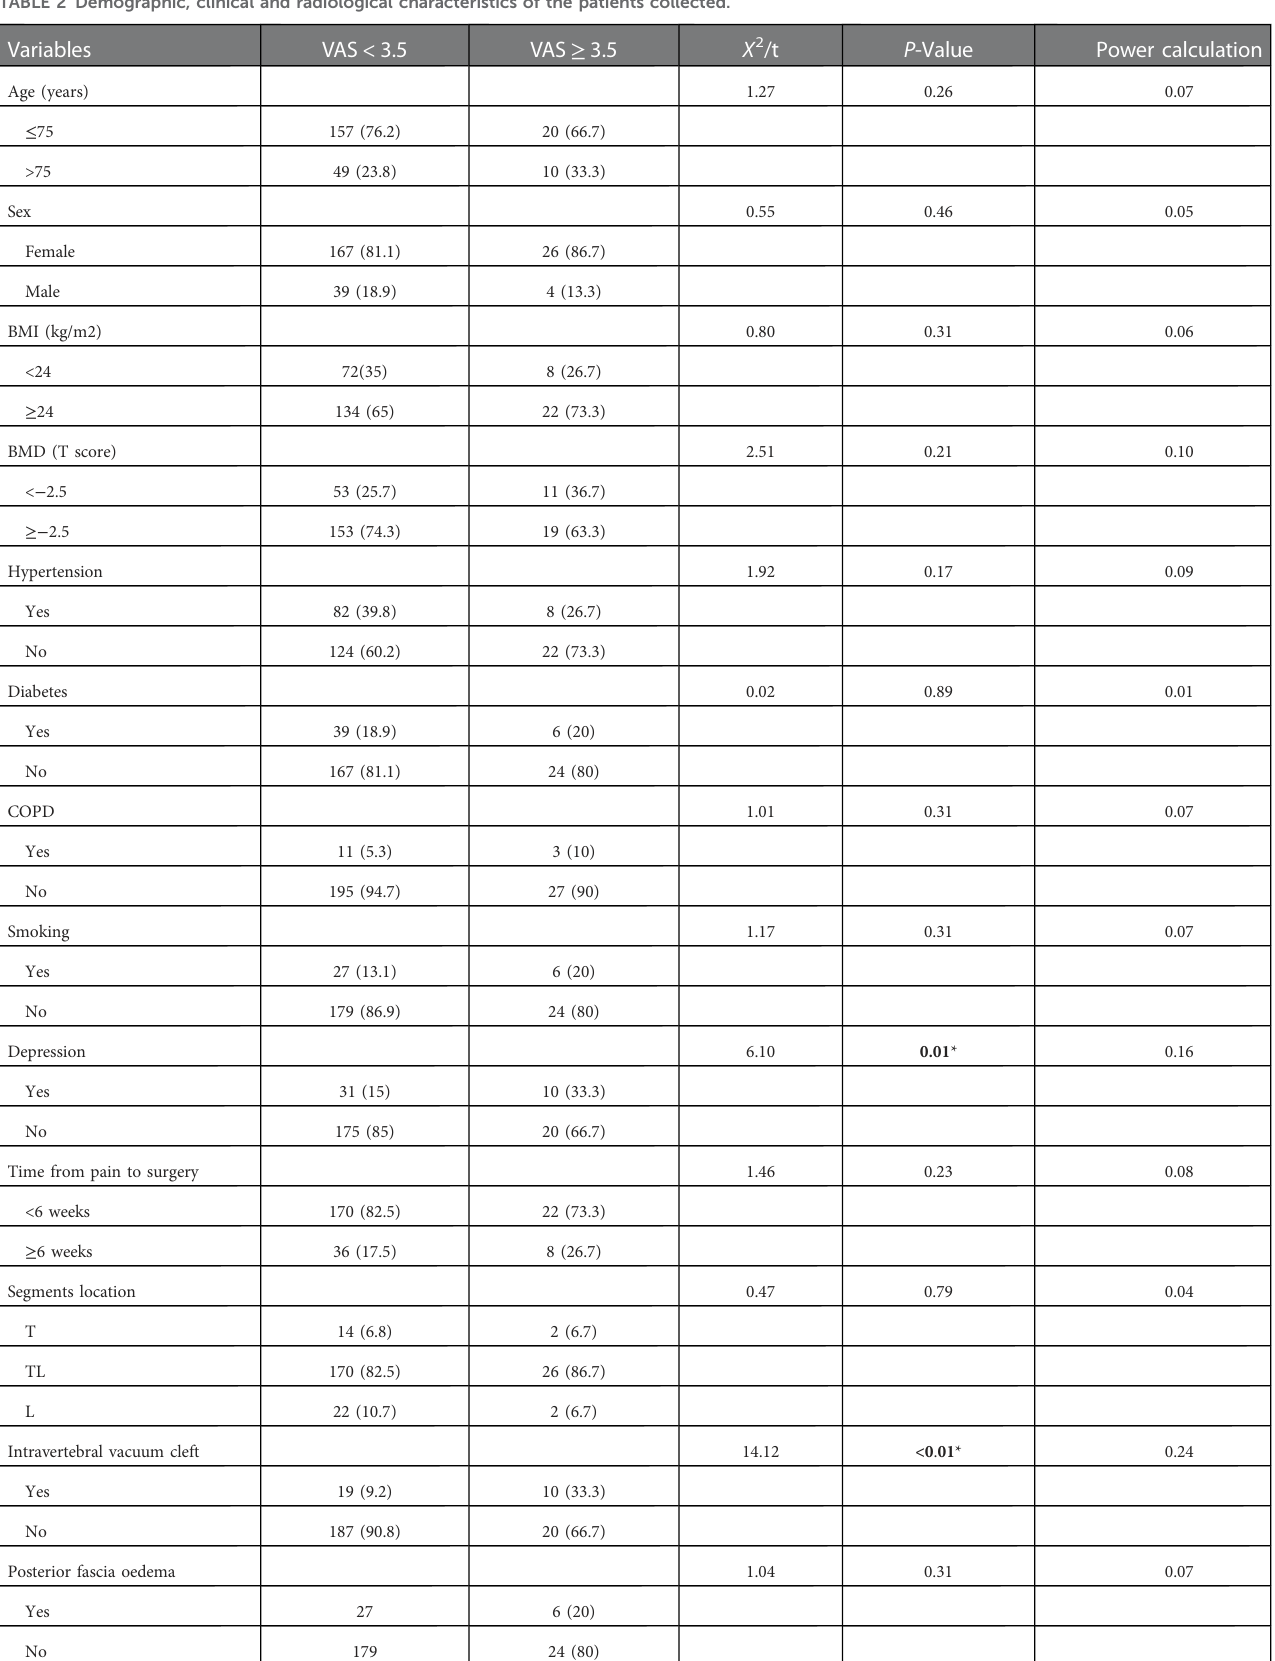
TABLE 2 Demographic, clinical and radiological characteristics of the patients